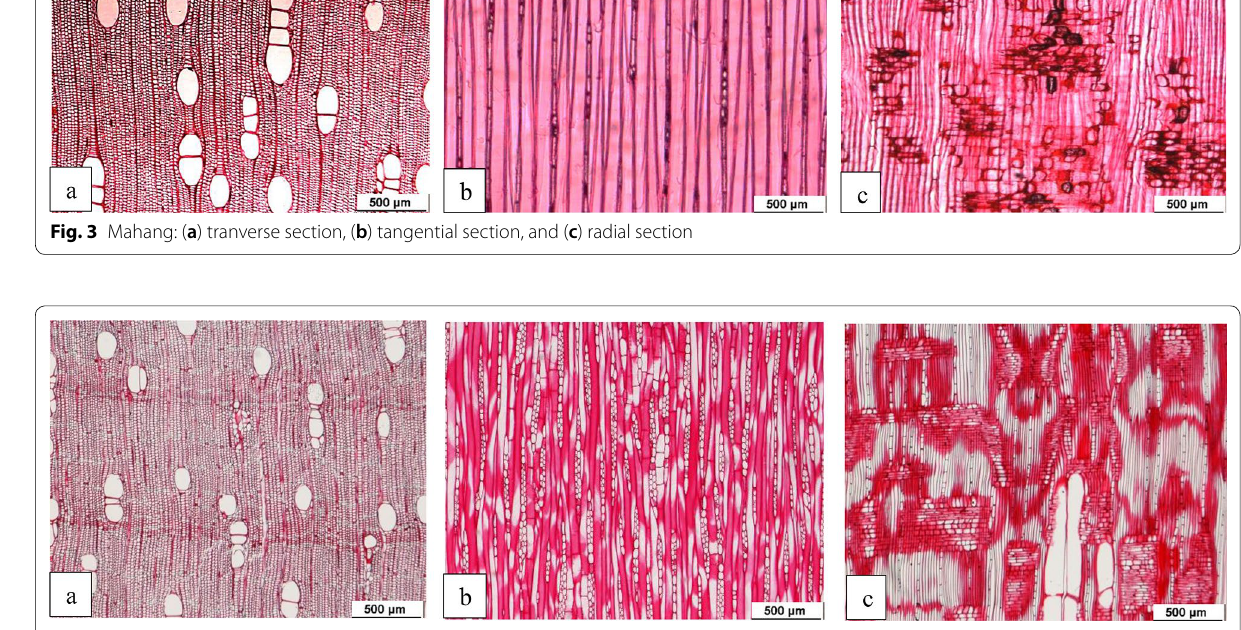
Fig. 4 Sesendok: ( a ) tranverse section, ( b ) tangential section, and ( c ) radial